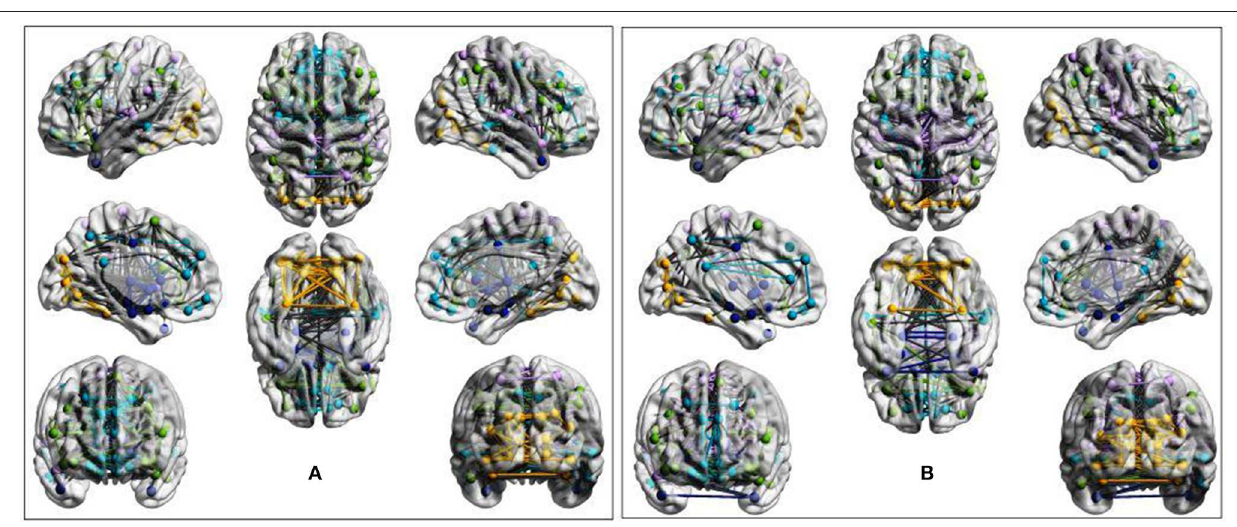
FIGURE 3 | Evidence of overactivation in the community colored in yellow observed in the average STA dataset network at the sparsity threshold T = 0.4, despite the community pattern showing an overall preservation of network morphology. (A) ASD cohort. (B) Control cohort. ROIs are defined according to the AAL90 atlas and colored on the basis of community assignment by using the Newman’s spectral algorithm. At this density level, group-average network overconnectivity was also observed in the OLI